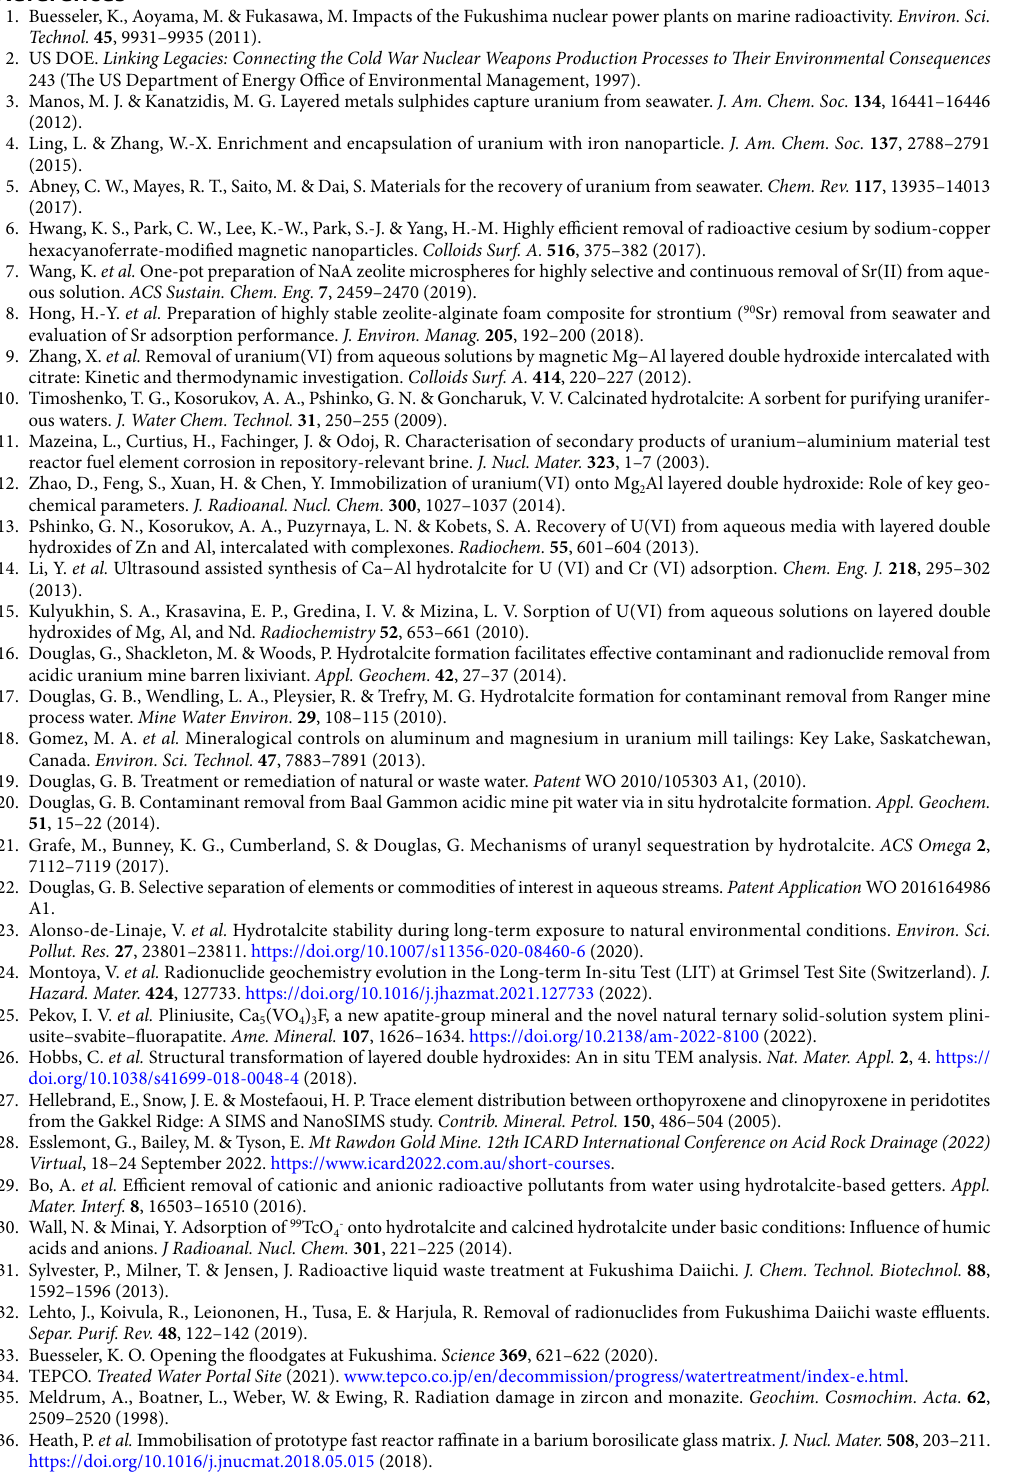
Supplementary Information for Fig. 4b contained in Supplementary Information: SI Fig.4b_Proxigram_data. xlsx. The datasets used and/or analysed during the current study available from the corresponding author on reasonable